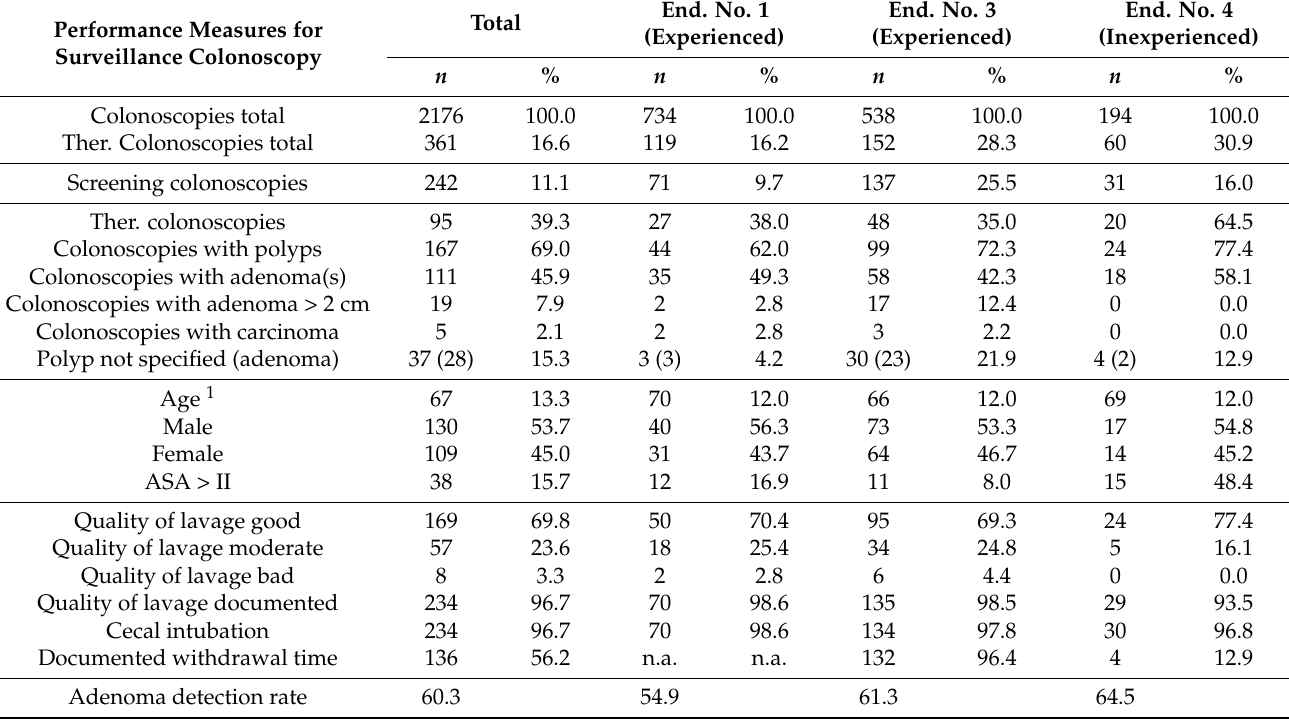
Table 5. Quality indicators of screening colonoscopy and quality of